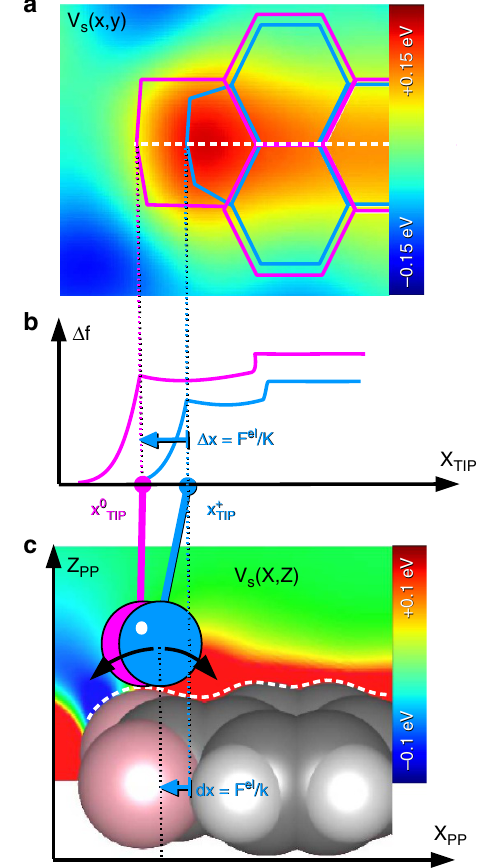
Figure 1 | Schematic view of the impact of the electrostatic forces on the high-resolution AFM images. ( a ) Blue and pink lines represent the positions of sharp edges observed in high-resolution AFM images acquired using positively charged and neutral tips, respectively. Corresponding x , y cut-plane of the Hartree potential V S ( x , y ) above the molecule is displayed in the background. ( b ) Variation of the frequency shift D f as function of the tip positions x TIP for the neutral x 0 and positively charged x þ probe TIP TIP particle. ( c ) The lateral relaxation D x of the probe particle with (blue) and without (pink) an effective charge on the tip is different above a molecule due to the presence of the electrostatic force. The electrostatic force originates from the interaction between the electrostatic potential of the molecule ( V S ) on the surface and the effective charge on the probe particle at its given position x PP